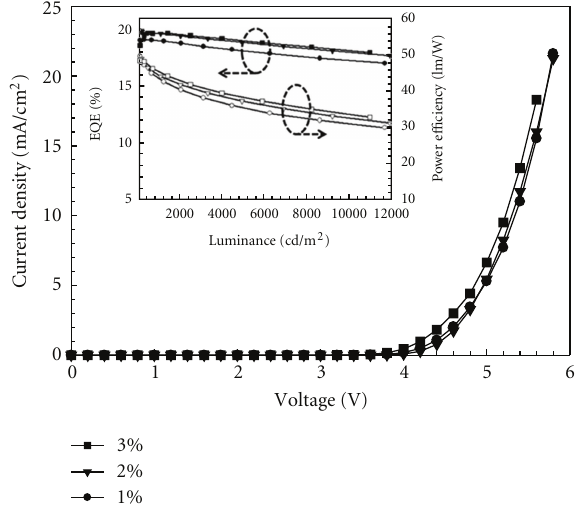
Figure 6: J - V characteristics of fabricated Bepp 2 : Ir(ppy) 3 green PHOLEDs with doping concentration from 1 to 3%. Inset shows the EQE and power e ffi ciency as a function of